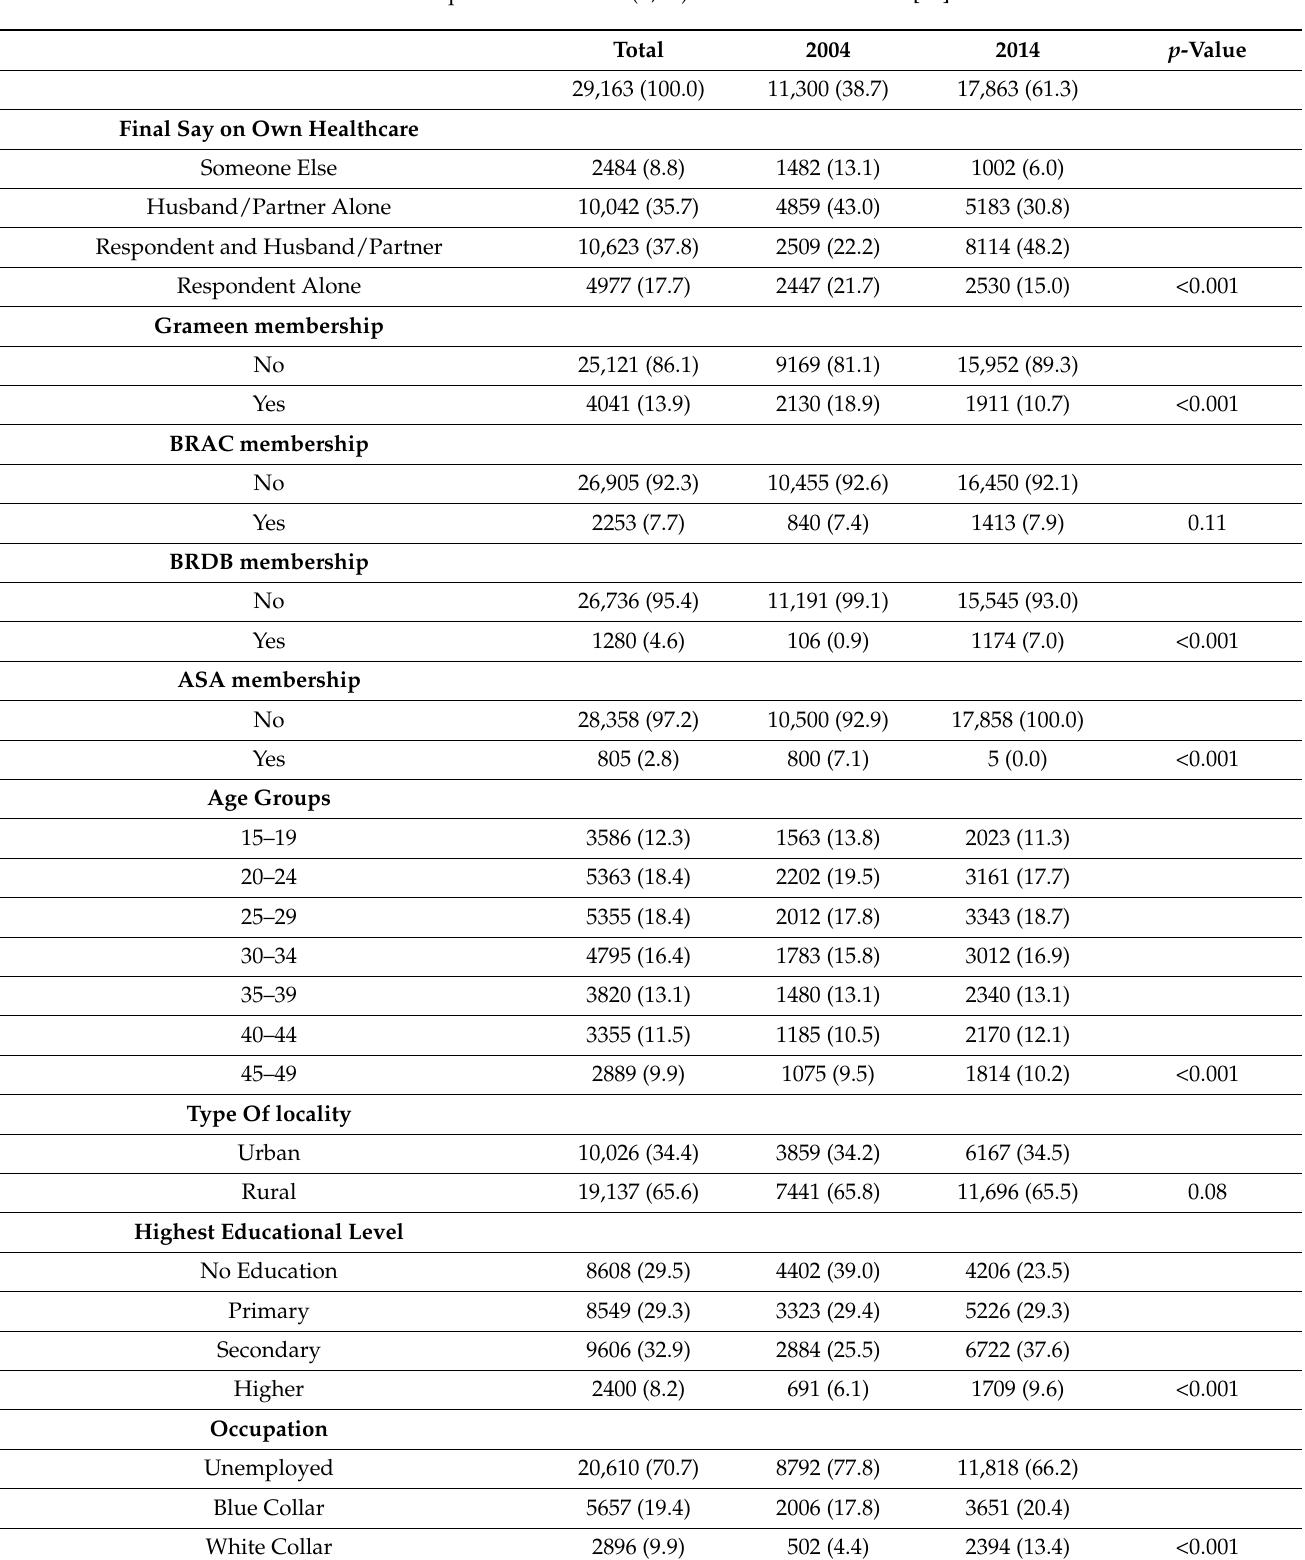
Table 1. Sample characteristics (n, %). BDHS 2004 and 2014